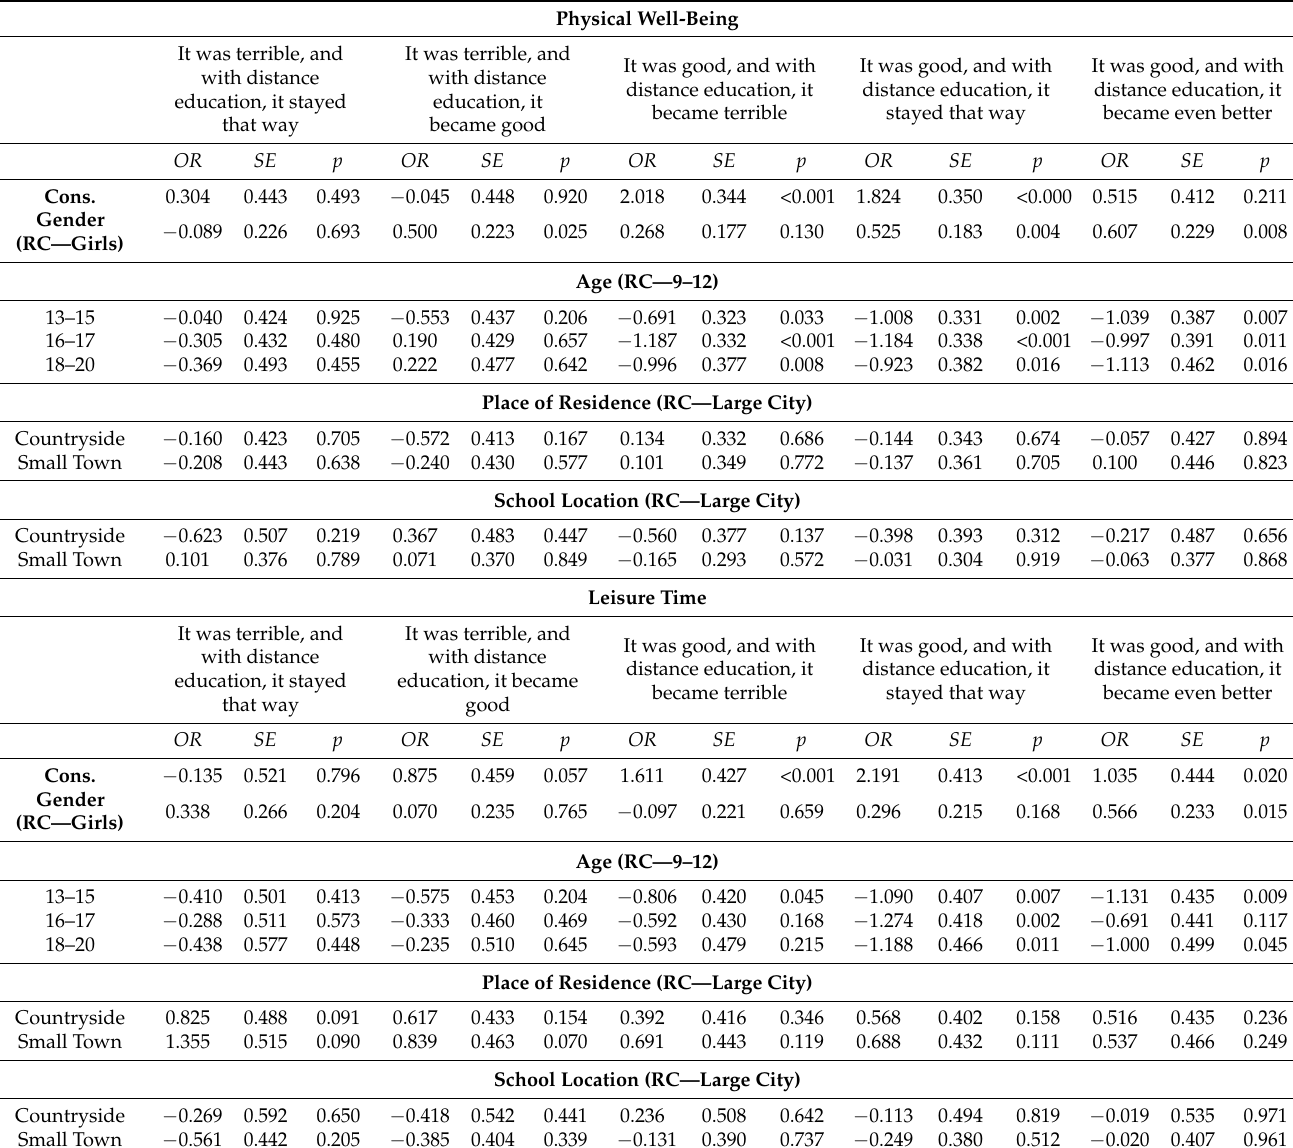
Table 2. Results of multinomial logistic